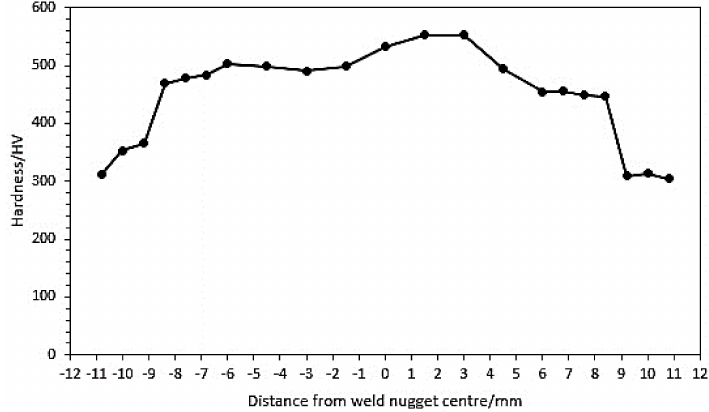
Figure 14. Vickers microhardness test results with the optimum